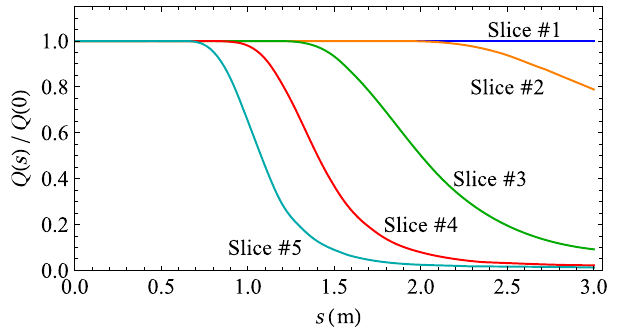
15. Bunch charge in five longitudinal slices (shown in Fig. 8) as a function of propagation distance through the structure. The beam is initially offset vertically by y 0 ¼ 50 μ m. F x is